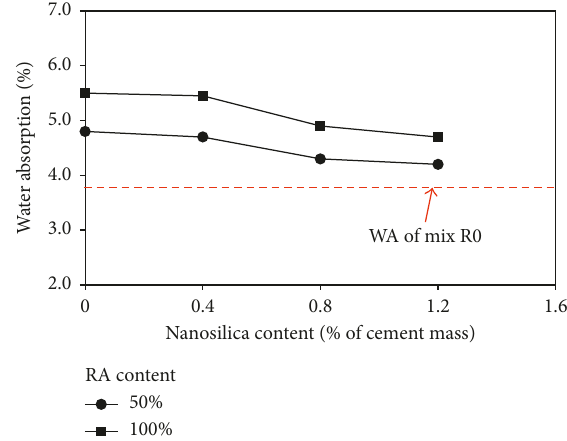
Figure 8: Effect of nanosilica particles content on the WA of RAC